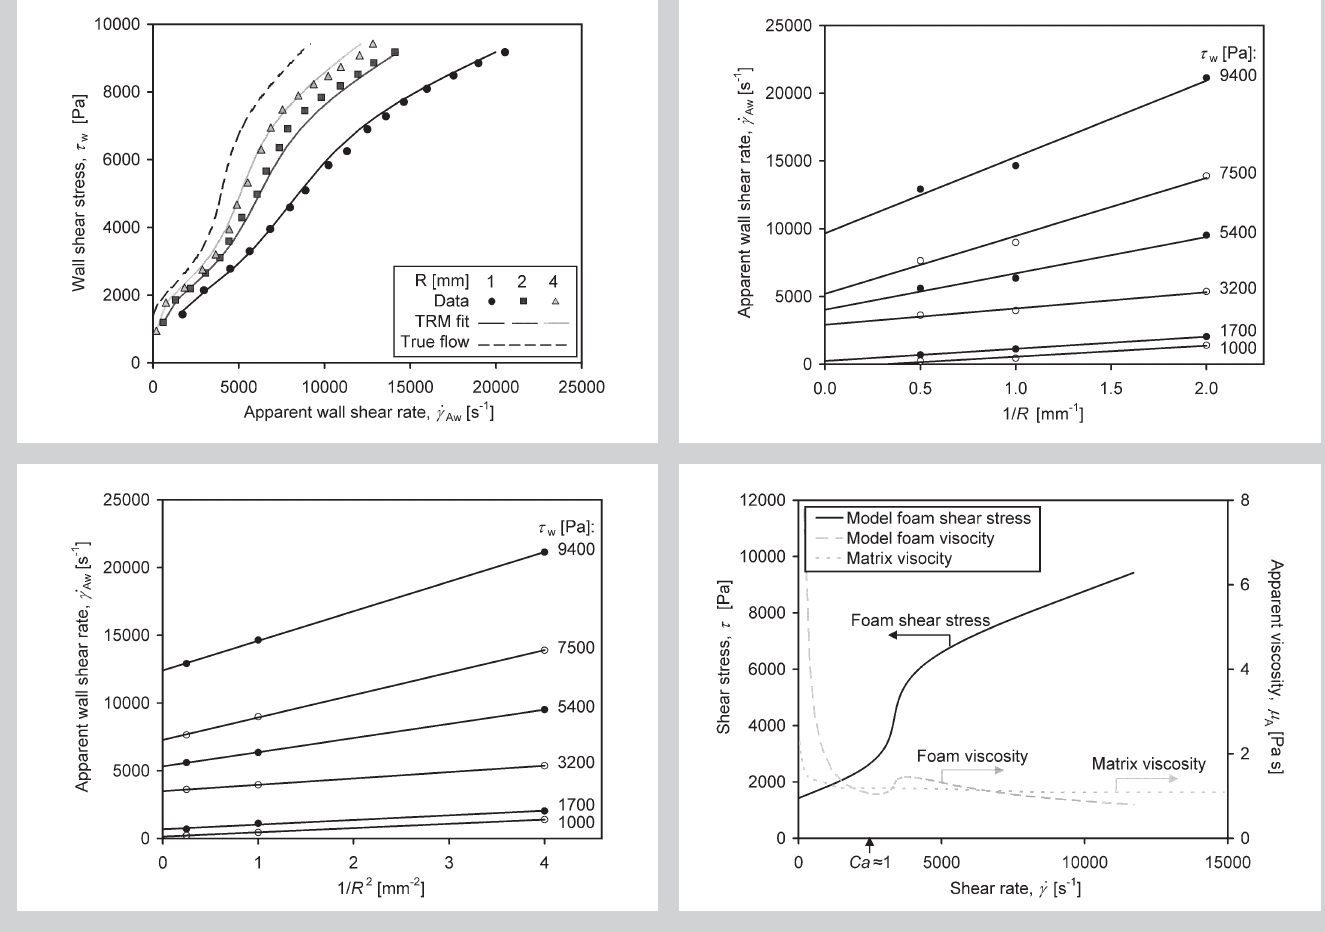
Figure 7 (left above): Model foam flow data and fitted flow curves ( f = 0.50 ± 0.15, T = - 5.0 ± 0.1°C). c Figure 8: Model foam Mooney plots = - 5.0 ± ( f = 0.50 ± 0.15, T c 0.1°C). (a – right above): CM plot of apparent shear rate against reciprocal of radius. (b – left below): JM plot of apparent shear rate against reciprocal of radius squared. Figure 9 (right below): Model foam fitted true shear stress and apparent viscosity against true shear rate ( f = 0.50 ± 0.15, T = -5.0 ± 0.1°C), compared c to matrix apparent viscosity ( f = 0, T = - 5.0 ± c